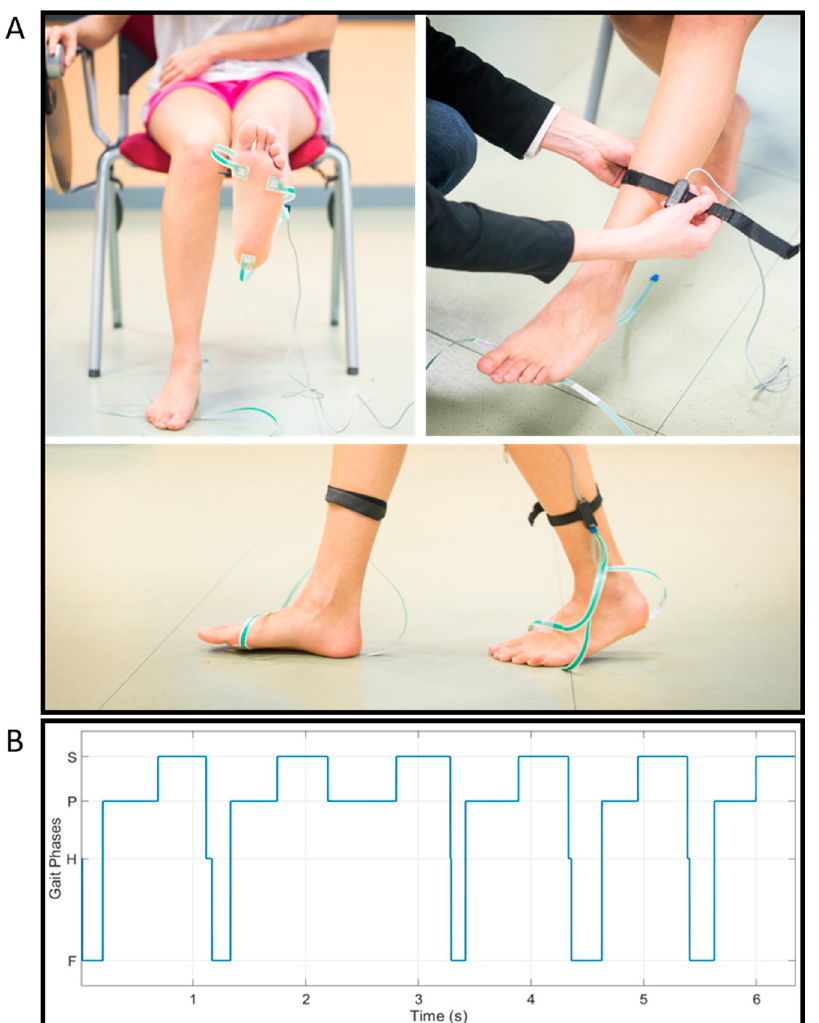
Figure 2. Panel ( A ) represents the acquisition system. Foot-switches were placed under the heel, the first, and the fifth metatarsal heads of each foot to detect the foot-floor contact events. Panel ( B ) shows an example of foot-switch signal acquired from the more-affected side of a representative PD patient of the sample population with the indication of the four gait phases (H: Heel Contact, F: Flat-Foot Contact, P: Push-Off, and S: Swing).